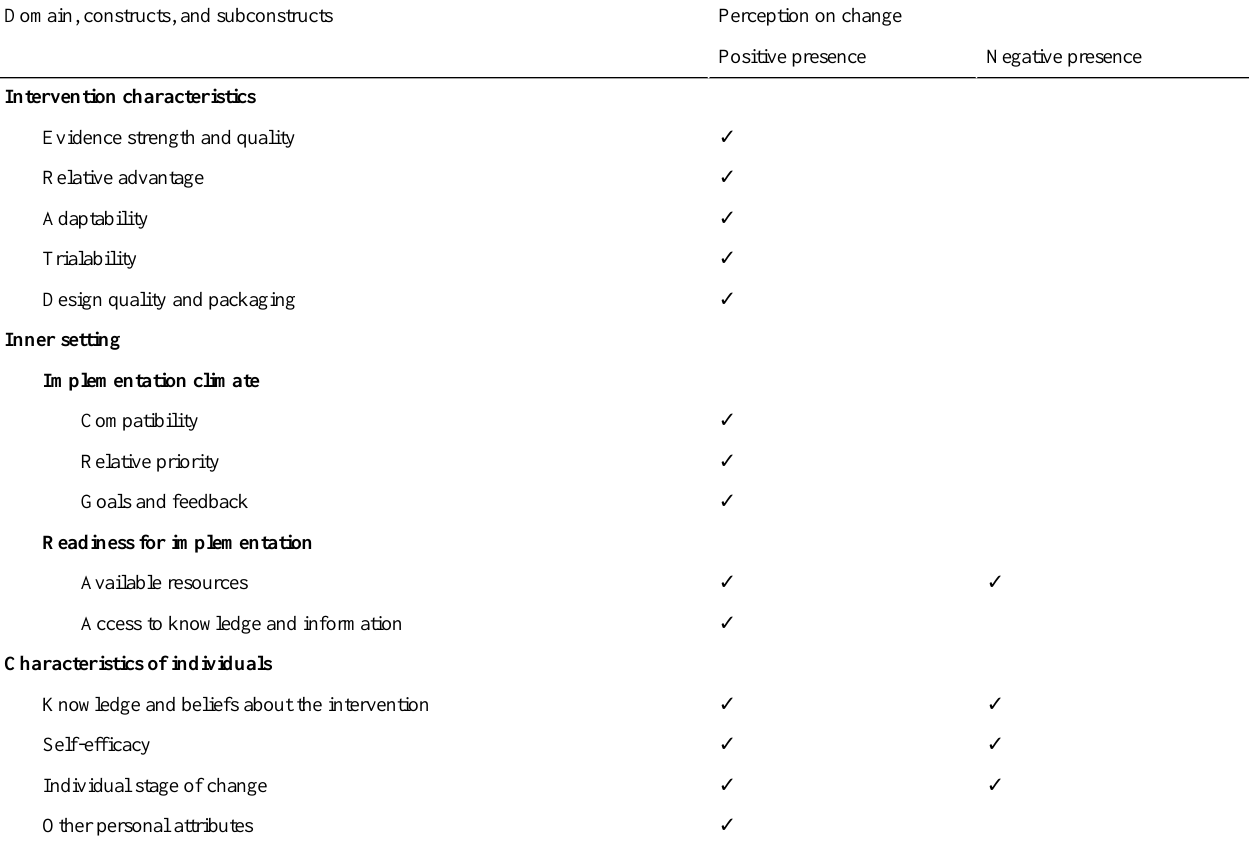
Table 2. Perception of the ChildSafe Mobile App mapped on consolidated framework for implementation research domains.